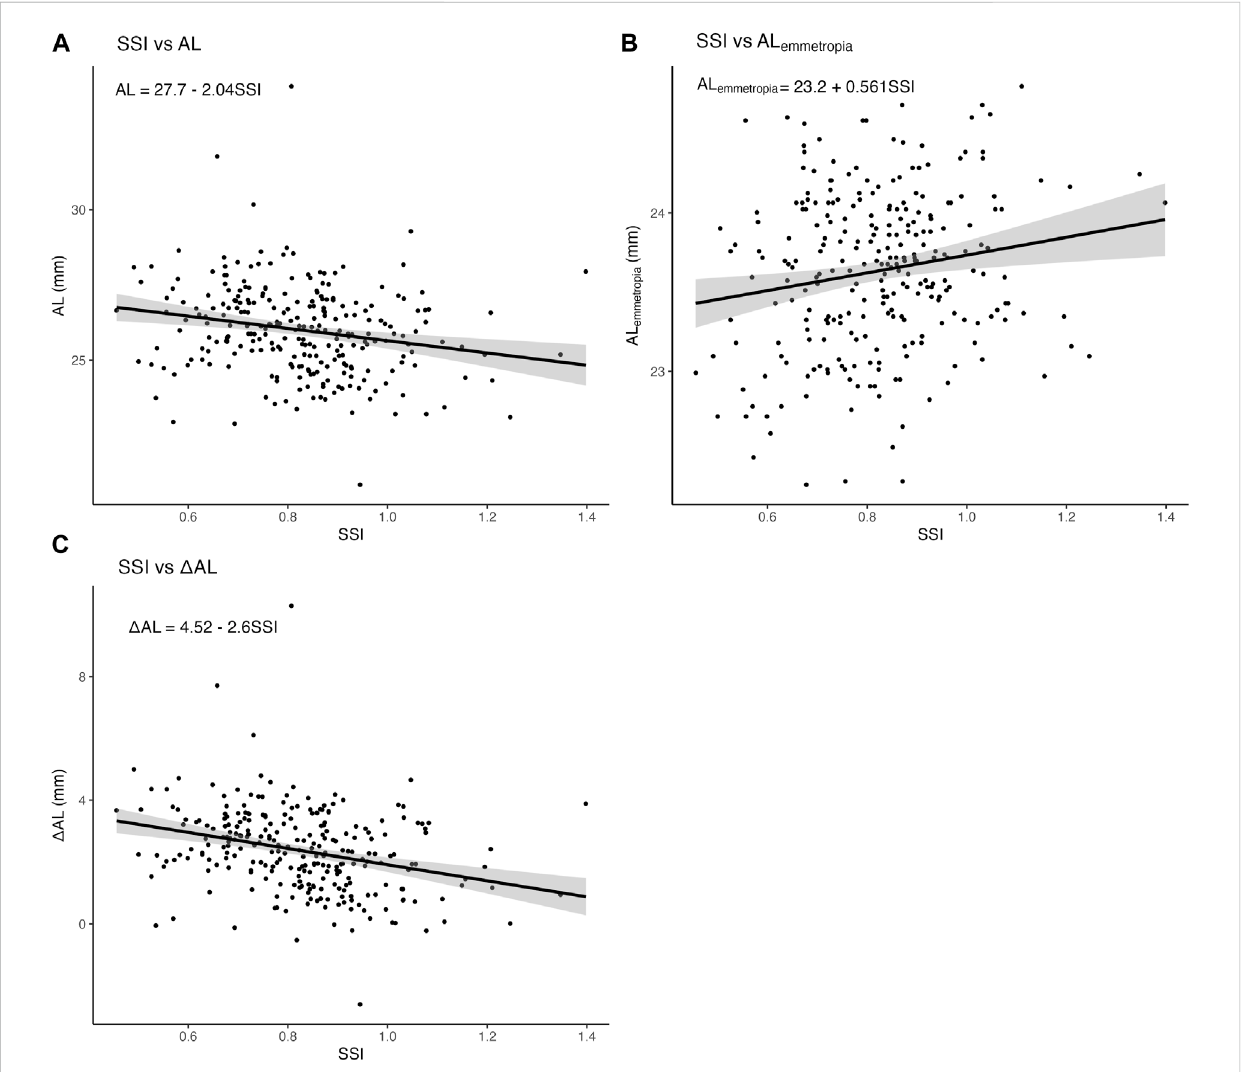
FIGURE 5 Associations of SSI with AL, AL emmetropia , and Δ AL. (A) shows the relationship between SSI and AL (B) shows the relationship between SSI and AL emmetropia (C) shows the relationship between SSI and Δ AL. Abbreviations: SSI, Stress-strain index; AL, Axial